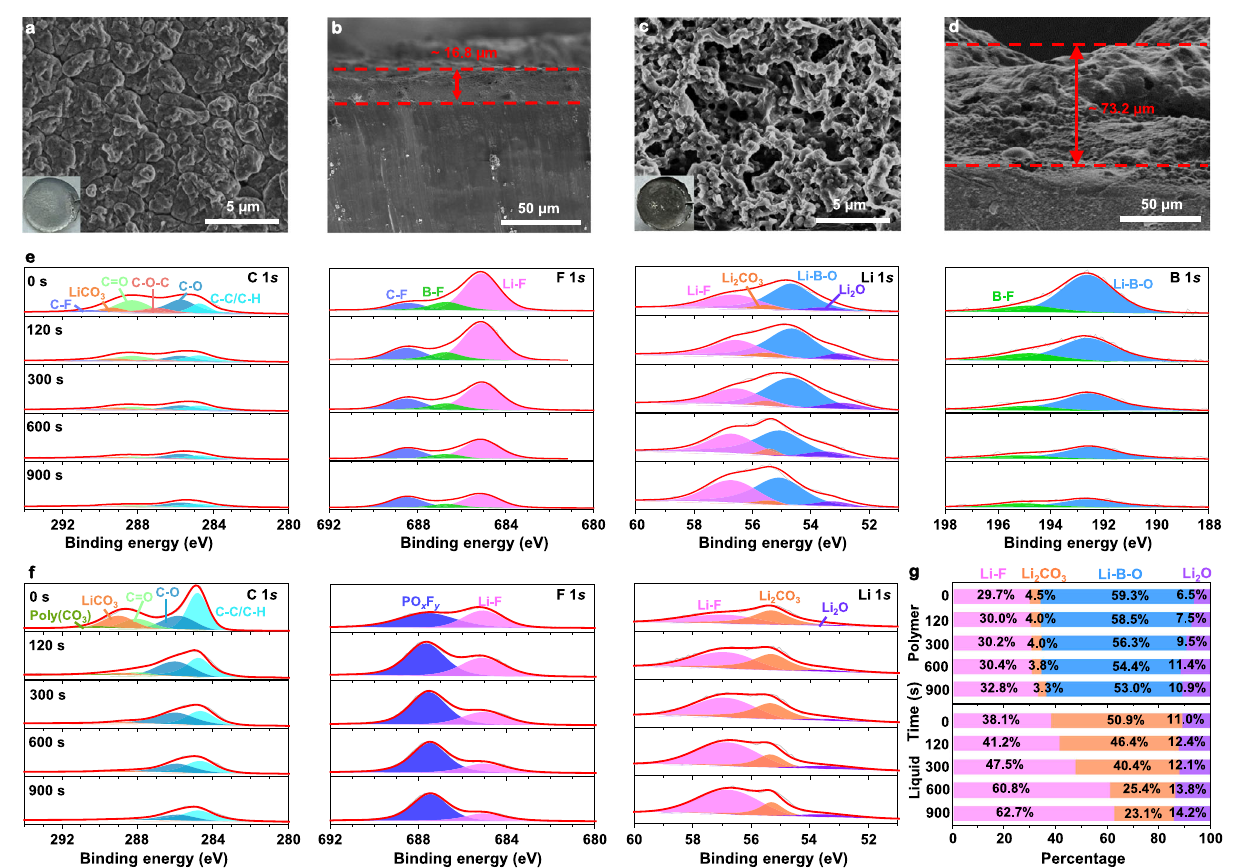
Fig. 4 | Ex situ postmortem physicochemical characterizations of Li metal electrodes cycled in liquid and polymer electrolytes. a – d SEM images illustrat- ing morphologies of the LMAs cycled in Li||Li coin cells with different electrolytes: surface morphologies ( a ) and cross-section views ( b ) using the designed polymer electrolyte, and surface morphologies ( c ) and cross-section views ( d ) using the